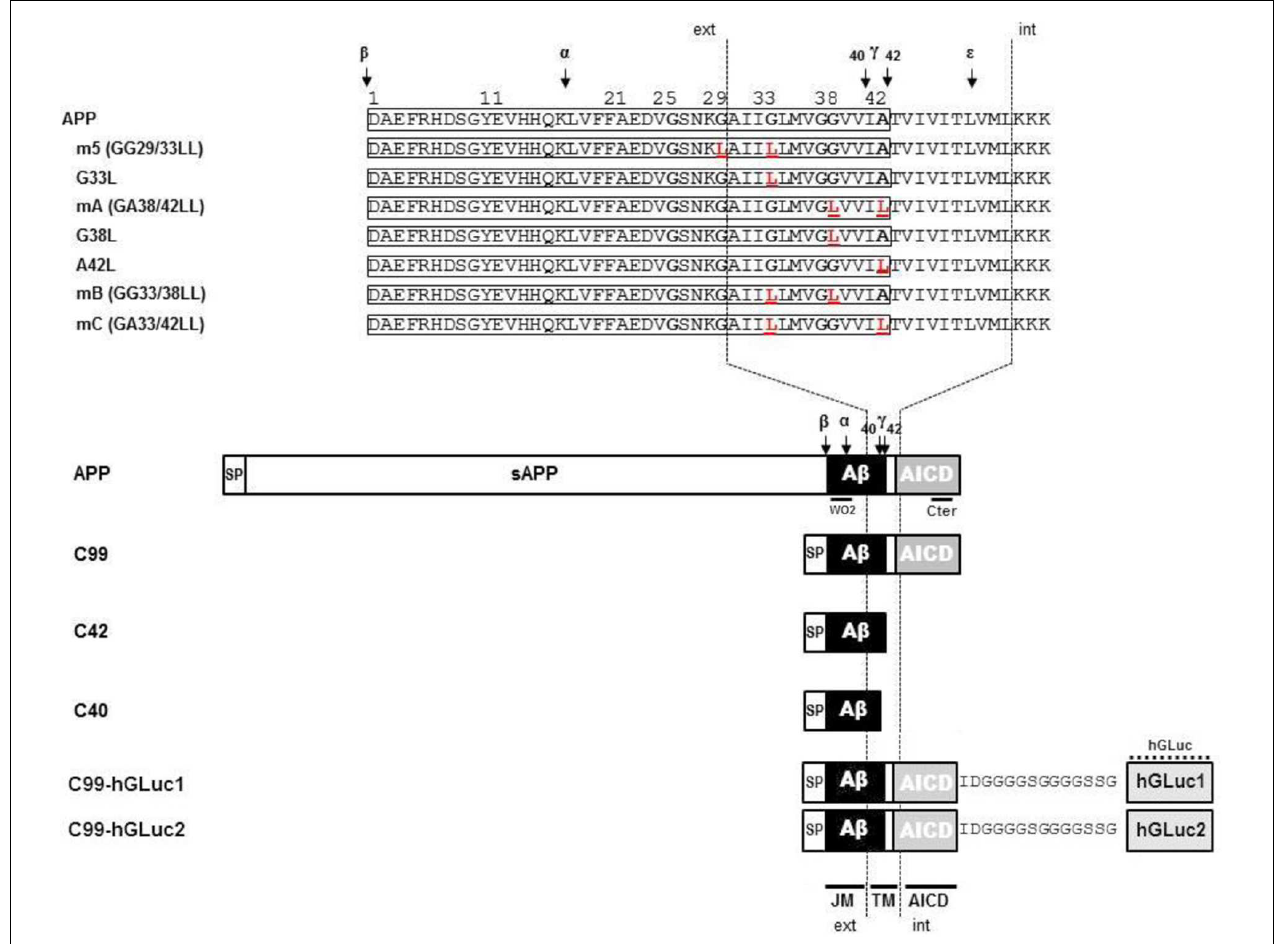
FIGURE 1 | Schematic representation of the different amyloid precursor protein (APP) mutants and APP constructs used for the study. Schematic representation of human APP and APP C-terminal fragments including the different mutants generated. Numbering corresponds to the amino acid position in the A β sequence. C99 corresponds to the APP β C-terminal fragment, C42 to the A β 42 peptide, and C40 to the A β 40 peptide. All C-terminal constructs are fused to the human APP signal peptide (SP). TM, Transmembrane region; JM, Juxtamembrane region; AICD, APP IntraCellular Domain; ext, extracellular; int, intracellular. The amino acid substitutions generated by site-directed mutagenesis are in red. The cleavage sites of α ( α )-, β ( β )-, and γ ( γ and ε )-secretases are indicated by arrows. C99-hGLuc1 and C99-hGLuc2 correspond to C99 constructs fused to hGLuc moieties used for the analysis of C99 dimerization in split luciferase assays. The epitopes recognized by the human-specific W0-2 antibody, the APP C-terminal and hGLuc antibodies are